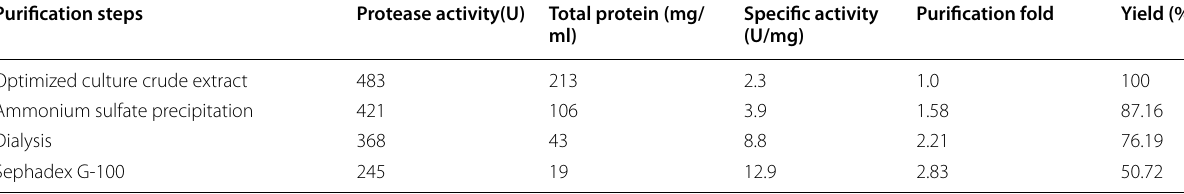
Table 2 Summary of purification factors of protease by Bacillus thuringiensis